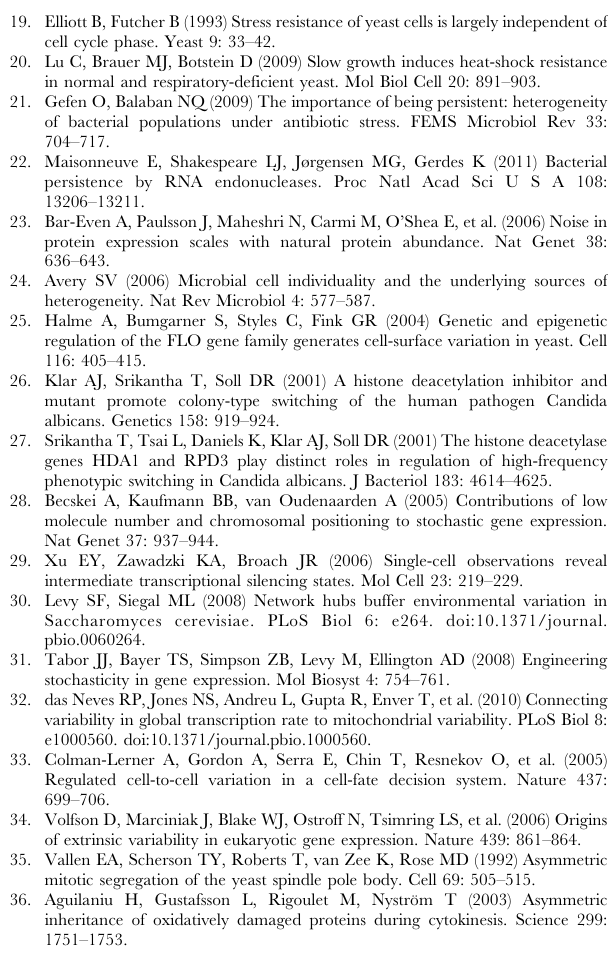
Figure S10 Cumulative specific growth rate distributions of TSL1 -GFP and TSL1 D -mCherry microcolonies that contained at least one cell that survived heat killing or no surviving cells. (PDF) Table S1 Characteristics of growth rate distributions of single gene deletion strains. (XLS) Table S2 Candidate genes involved in bet hedging. (XLS) Table S3 Gene ontology enrichment of noisy gene products whose average expression correlates with the bulk growth rate. (XLS) Video S1 A typical field of microcolony growth. Cells in logarithmic growth are plated at a low density on a glass-bottomed multi-well plate and low-magnification time-lapse bright-field images are captured each hour (left). Custom-written software tracks colony area over time (right). Colonies that touch each other or the edge of the field discontinue being tracked. Notice an extremely slow-growing dark-purple colony at the lower left of the field. (MOV) Video S2 A video of the same colonies shown in Figure 1A. (MOV)